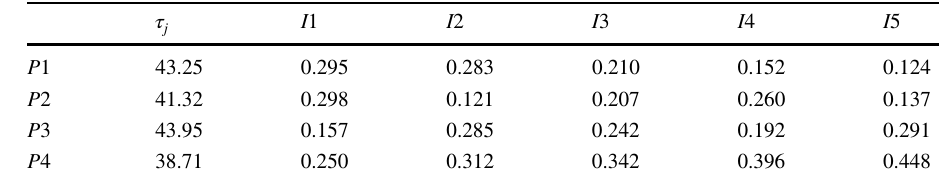
Table 3 Estimated model